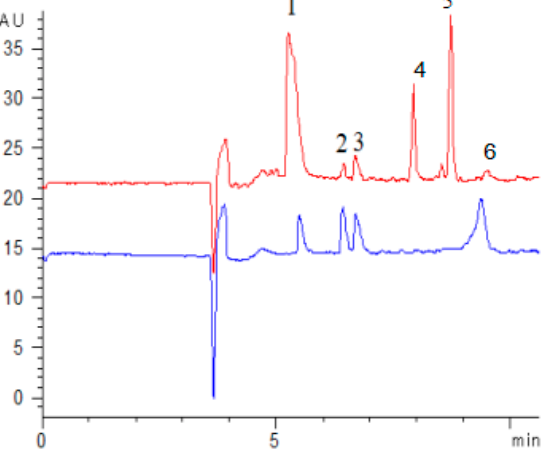
Figure 4. Capillary electropherograms of four compounds in mixed standard solution (red) and sample extracts (blue) ( n = 3), (1 Rutin, 2 Kaempferol-3-rutinoside, 3 Narcissoside, 4 Ferrozine, 5 [Fe(ferrozine) 3 ] 2+ ,6 Quercetin).